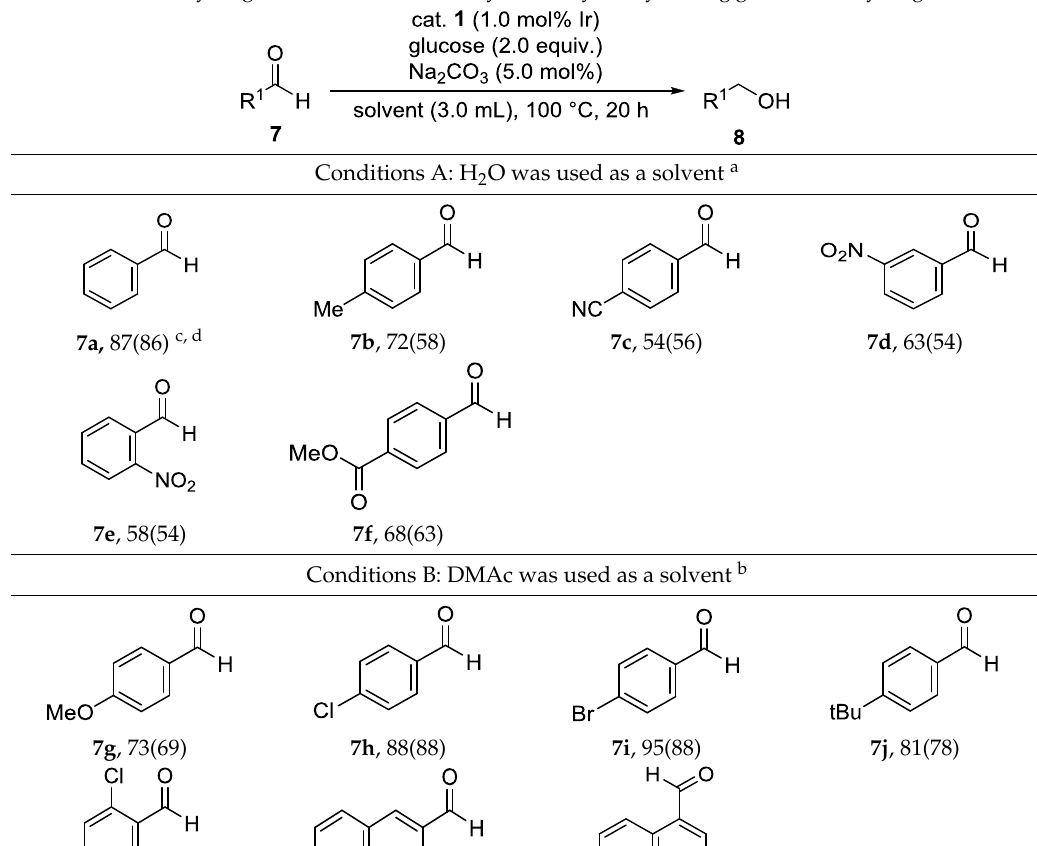
Table 3. Transfer hydrogenation of various aldehydes catalyzed by 1 using glucose as a hydrogen donor.